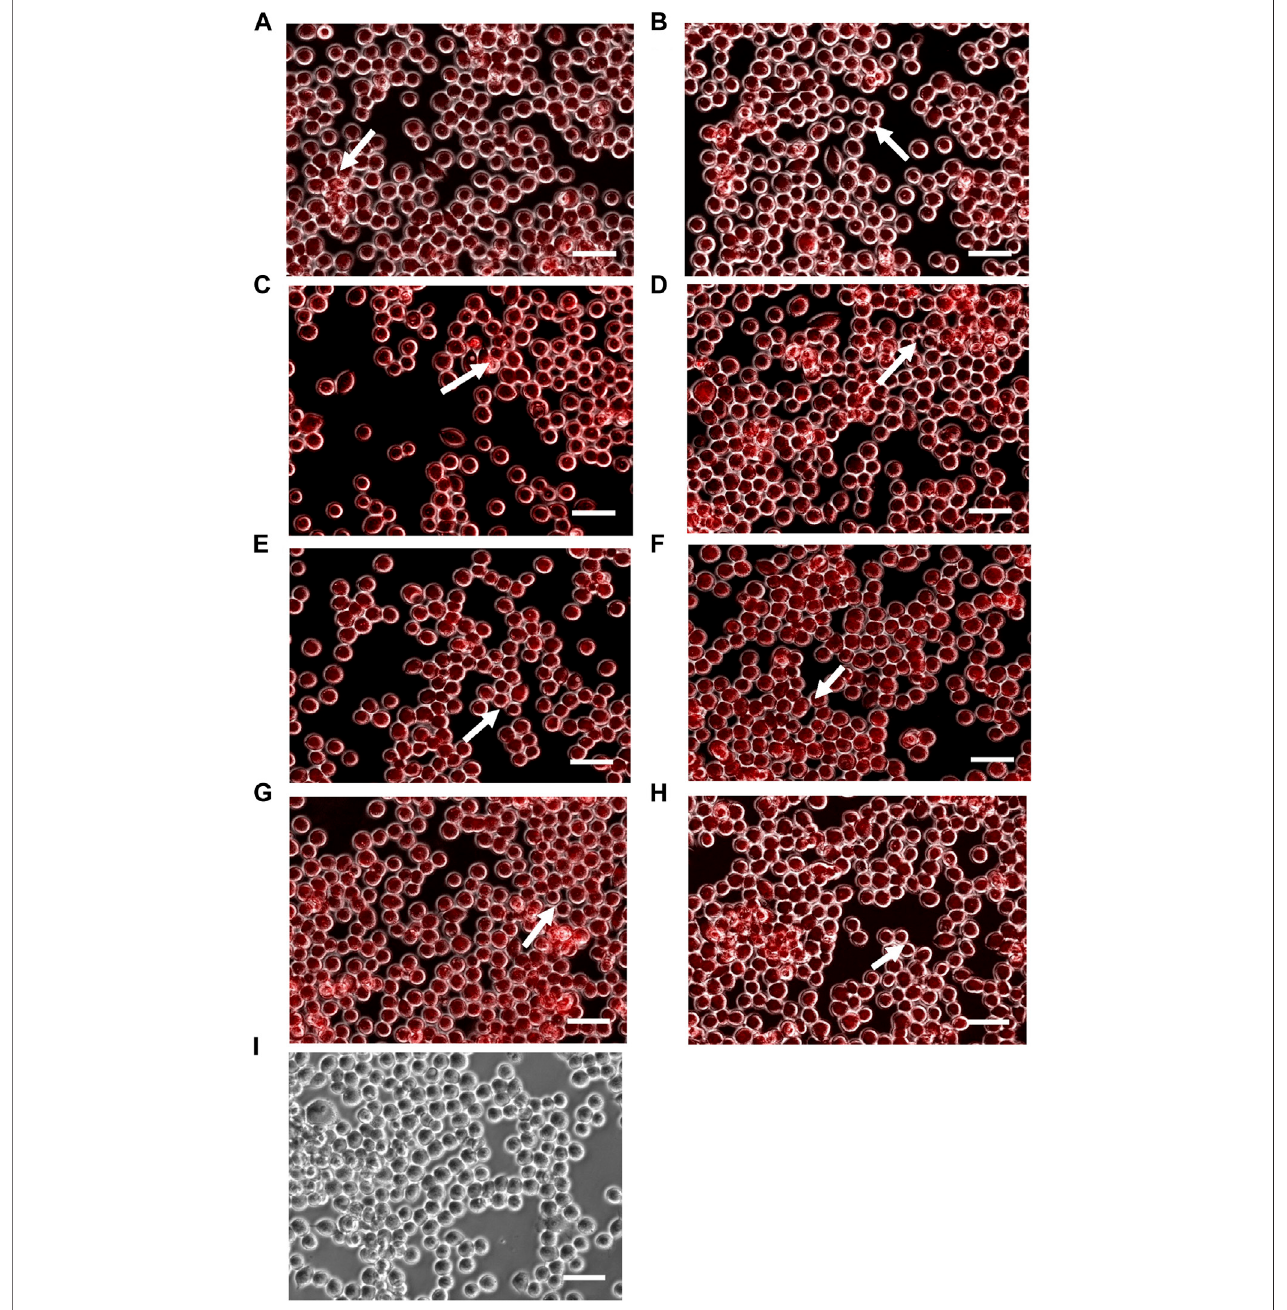
FIGURE 3 | Intracellular accumulation of doxorubicin within SW620 cells, following treatment with formulations (A) T0P0, (B) T0P1, (C) T1P0, (D) T1P1 (E) T1P2, (F) T2P1, (G) T2P2 as well as (H) doxorubicin solution and (I) no treatment (as control groups). Arrows represents accumulation of doxorubicin in the nucleus (magni fi cation: × 10, scale bar: 10